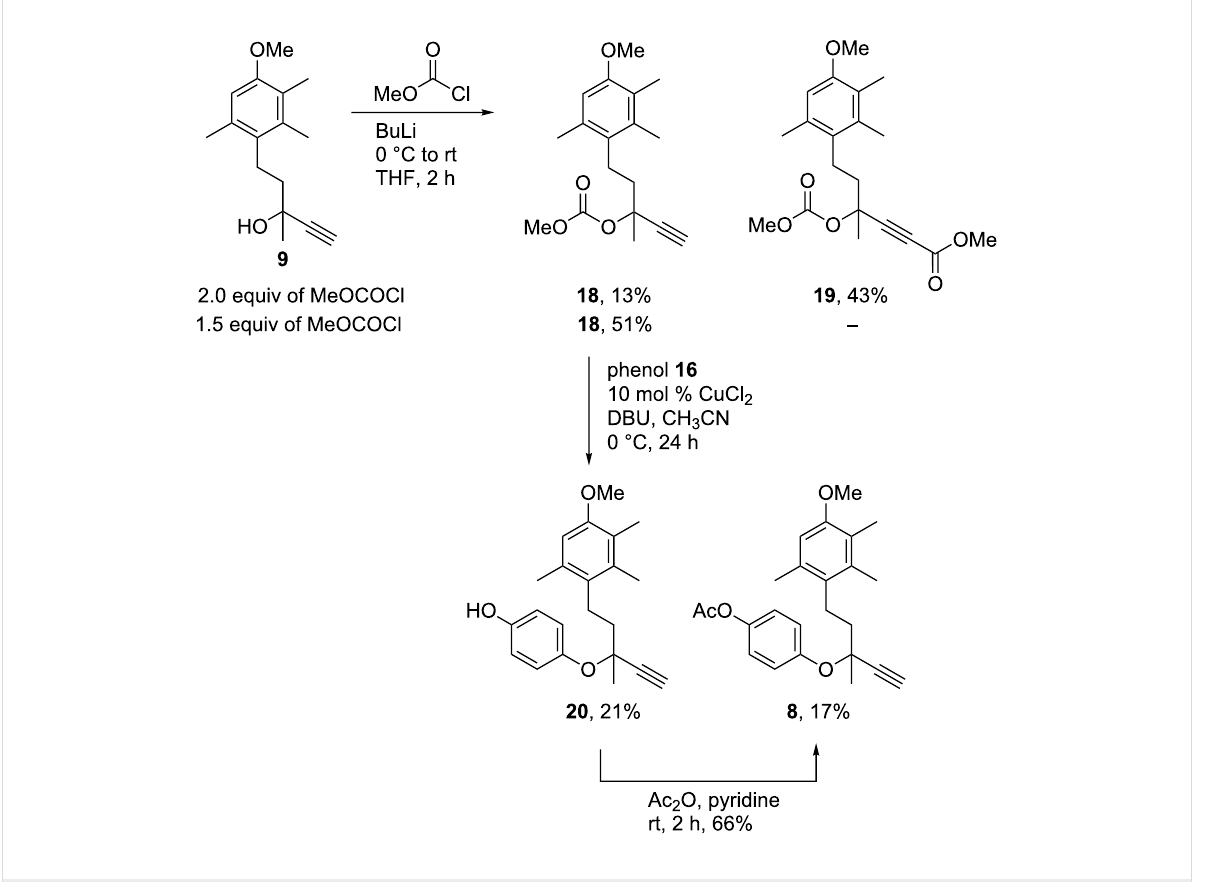
Scheme 3: Synthesis of propargyl ether 8 through carbonate 18 .